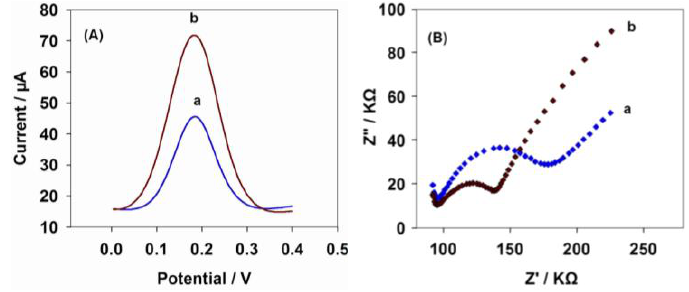
Figure 3. Electrochemical characterization of CNTs-PBA/GC electrode. ( A ) DPV response of the CNTs-PBA/GC electrode (curve a) and the CNTs-PBA/GAs/GC electrode (curve b); ( B ) Electrochemical impedance spectroscopy (EIS) for the CNTs-PBA/GC electrode (curve a) and the CNTs-PBA/GAs/GC electrode (curve b). The concentration of GAs (α-solanine) is 25 mM in Fe(CN) 63−/4− (pH 7.2, 2.5